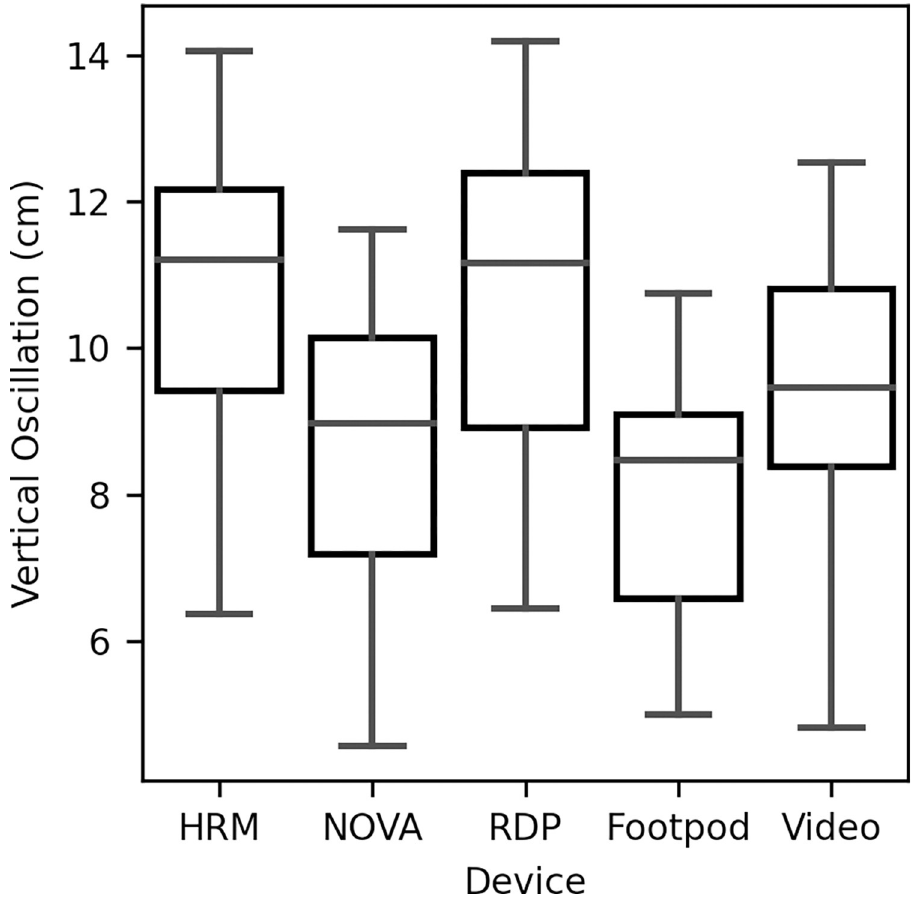
Fig 3. Average vertical oscillation for each method. The box plot shows the distribution of VO values for each device. Median VO and quartiles 1 (Q1) and 3 (Q3) are show by the box, while lower and upper bars are Q1–1.5 � Inter- Quartile Range and Q3 + 1.5 � Inter-Quartile Range, respectively. There were no outliers above or below the bars for any method.